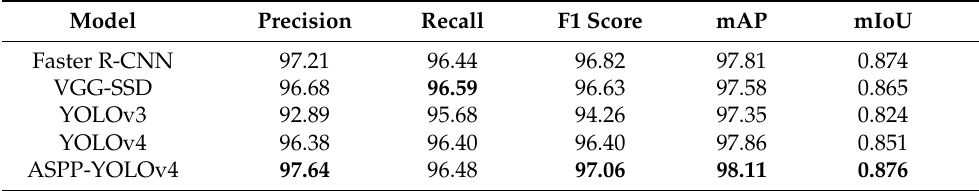
Table 3. Experimental results of different models for symbol recognition.